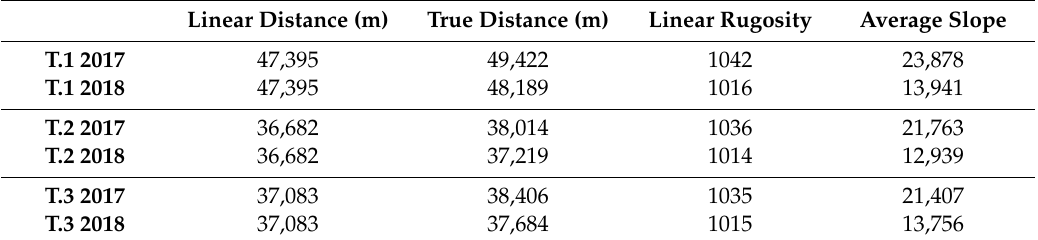
Figure 8. A portion of the orthomosaic and DTM of Area 2 monitored in February 2017 ( a – c ) and November 2018 ( d – f ). Colored lines in ( a – d ) and ( b – e ) represent selected transects in which linear rugosity and average slope have been computed (see the text for an explanation and Table 4). ( c , f ) Images representing the rugosity maps of the area around the transects. Table 3. Variation in linear rugosity and average slope between years along the transects T1, T2 and T3 in Area 4 (Figure 6). Linear Distance (m) True Distance (m) Linear Rugosity Average Slope